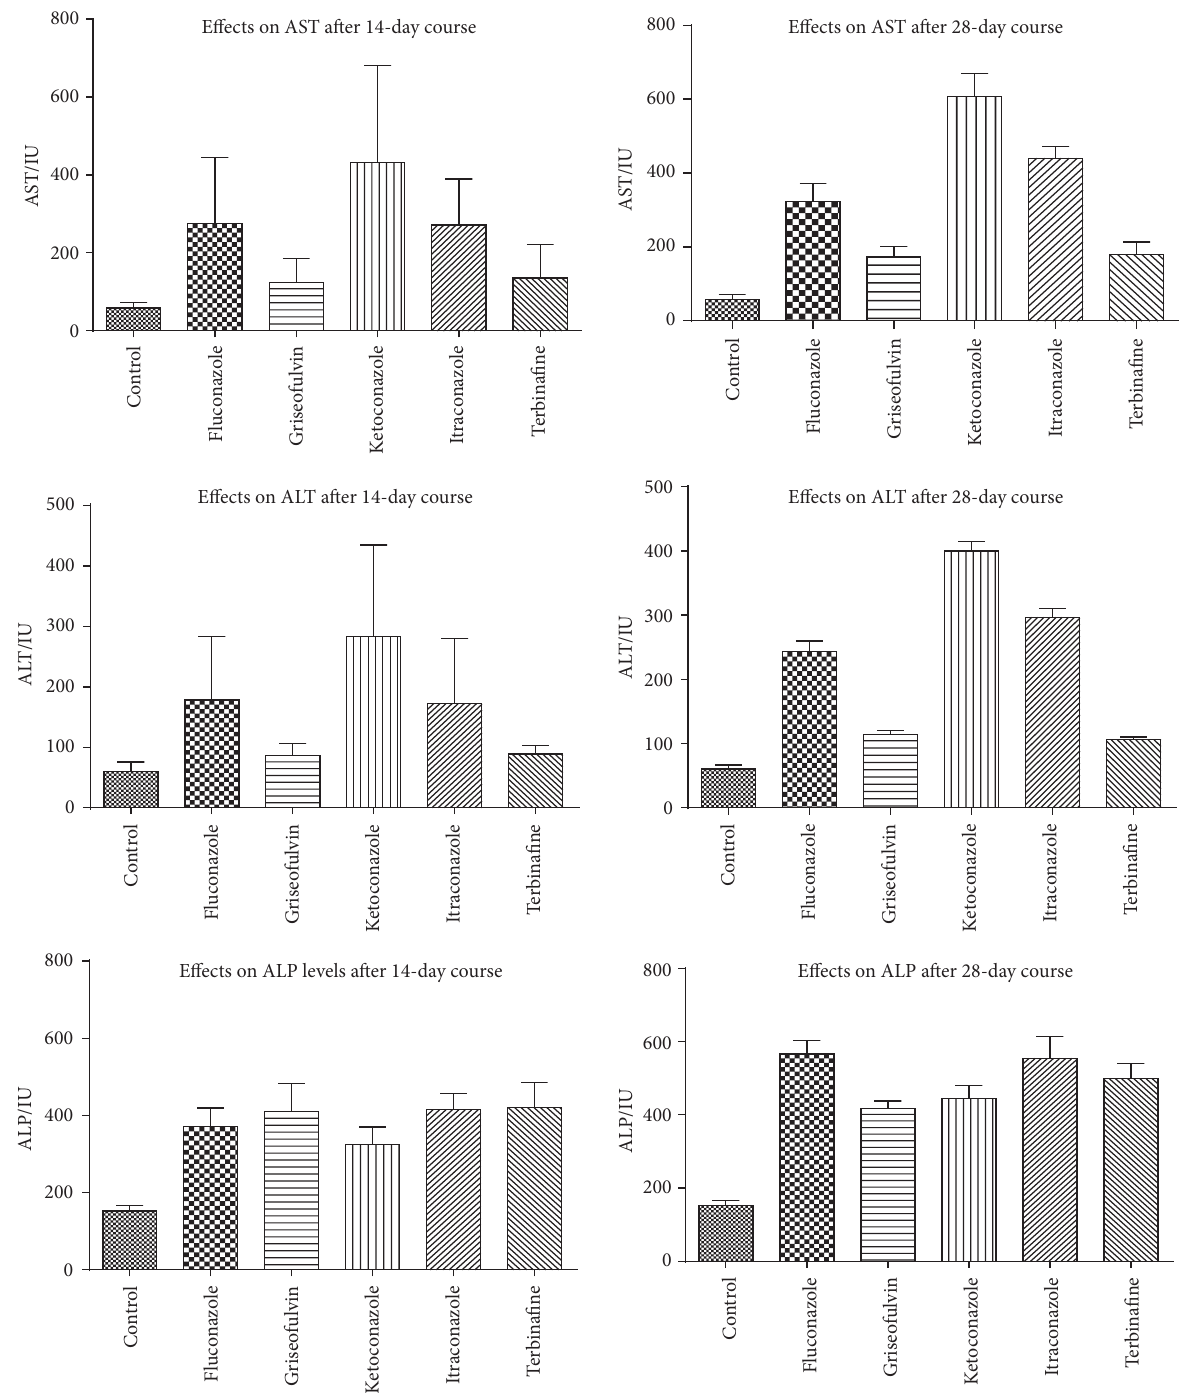
Figure 1: Serum levels of AST, ALT, and ALP, for the control group and the groups that received 14- and 28-day courses of fluconazole, griseofulvin, ketoconazole, itraconazole, and terbinafine.